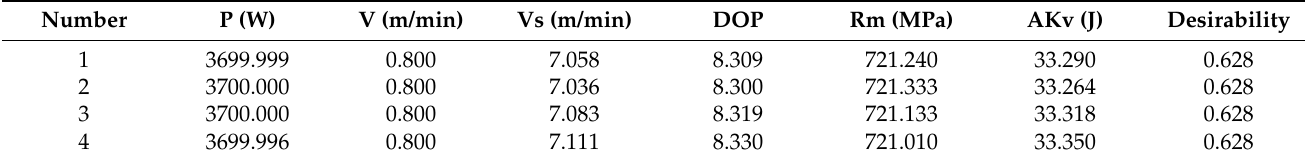
Table 10. Model optimization results.